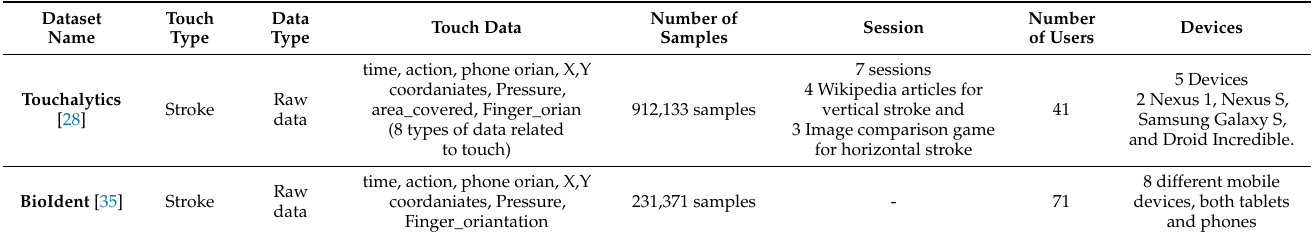
Table 2. The specifications of the Touchalytics and BioIdent